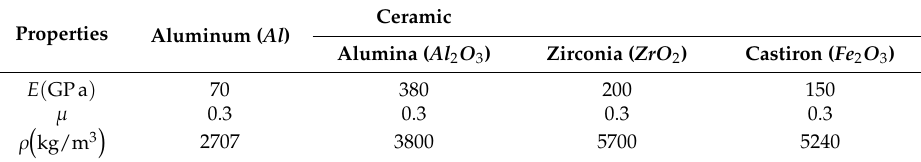
Table 1. Material properties of the FGM plates used for the analysis [32].